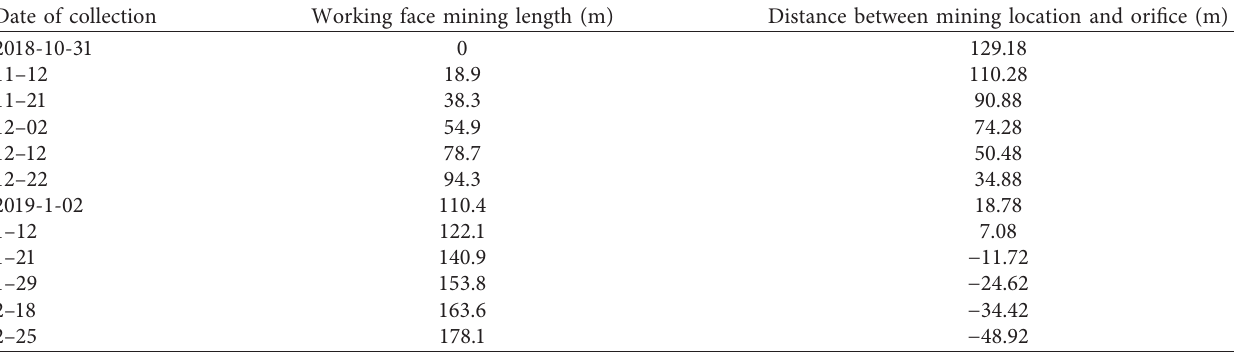
Table 3: Working face propulsion data record table.